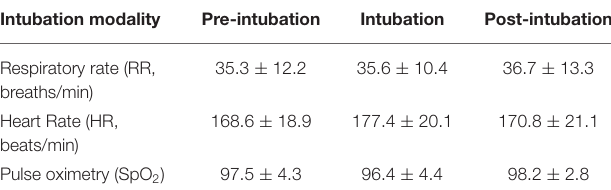
TABLE 3 | Other arterial blood gas parameters at different time points, in presence (T 1 , T 3 ) or absence (T 0 , T 2 ) of O 2 supplementation, over the course of the